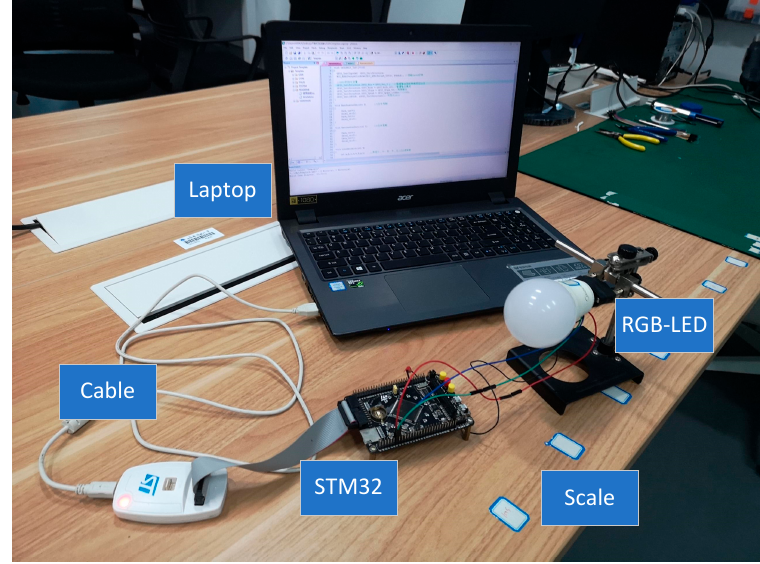
Figure 20. LED transmitter platform.